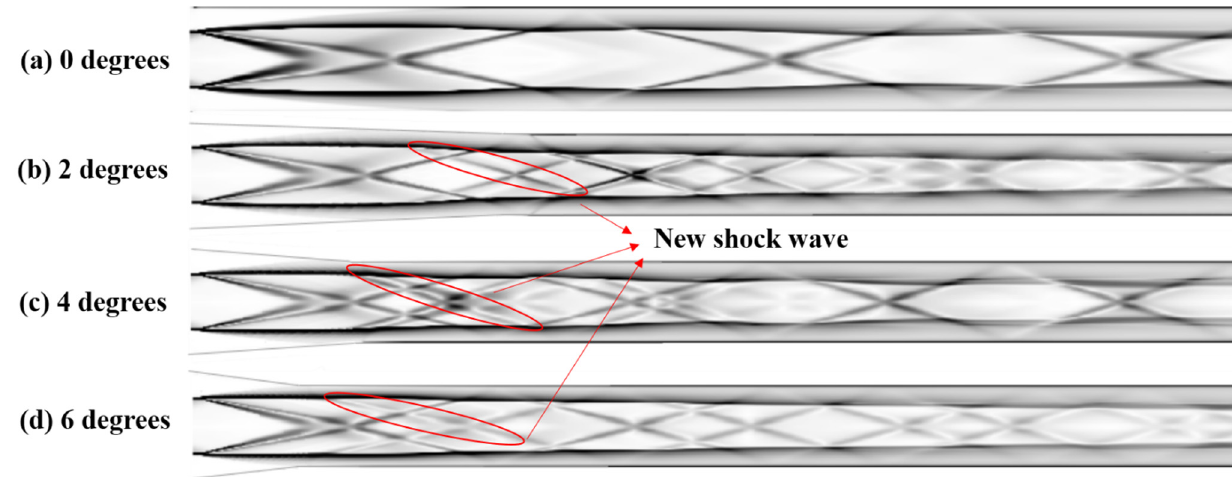
Figure 13. Numerical synthetic Schlieren with different φ .